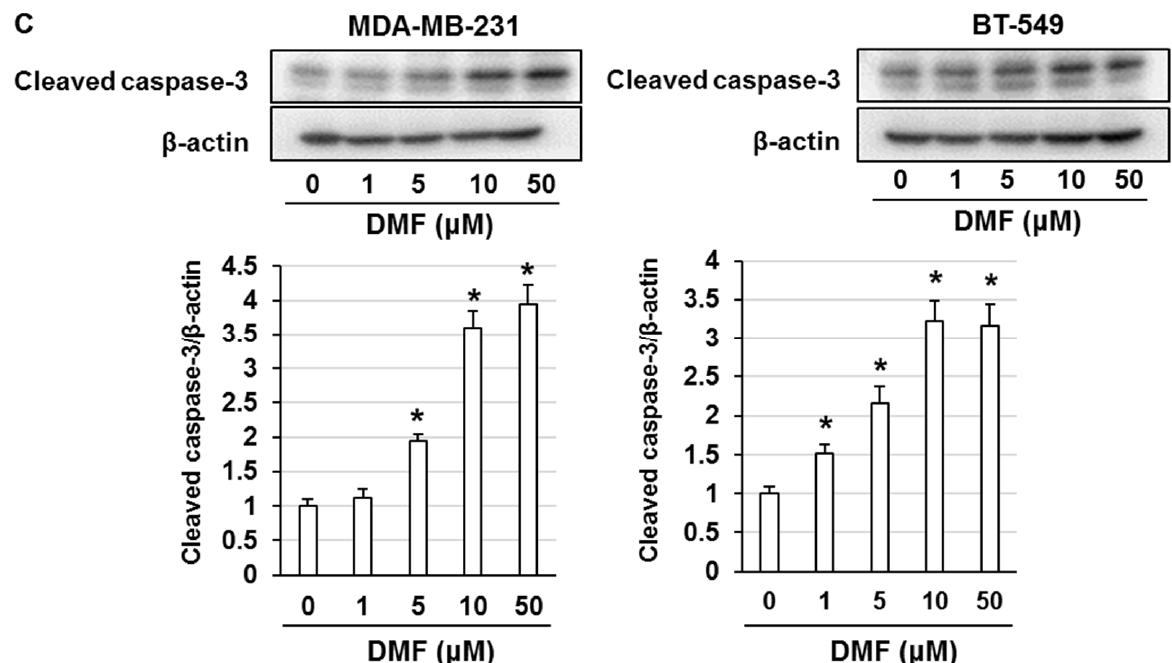
Figure 3. DMF induced apoptosis in MDA-MB-231 and BT-549 cells. ( A ) Viability of DMF-treated MCF-10A, MDA-MB-231, and BT-549 cells, as determined by the trypan blue staining assay. Cells were treated with the shown concentrations of DMF for 3 days. The results are representative of five independent experiments. * p < 0.01 vs. untreated cells. ( B ) MDA-MB-231 and BT-549 cells were treated with the shown concentrations of DMF for 72 h and then stained using an Annexin V apoptosis assay kit. The results are representative of four independent experiments. * p < 0.01 vs. untreated cells. ( C ) Cell lysates were evaluated by immunoblotting using the shown antibodies. The content of cleaved caspase-3 was quantified and standardized to the content of β -actin. The results are representative of three independent experiments. * p < 0.01 vs. untreated cells.